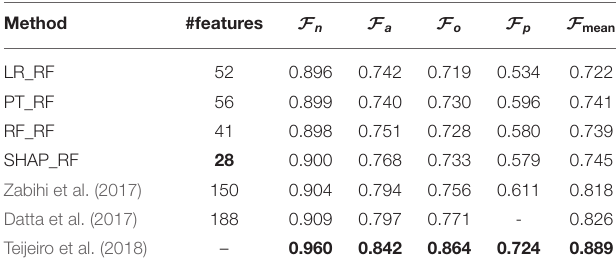
TABLE 5 | Comparison with state-of-the-art methods on CinC/PhysioNet dataset based on